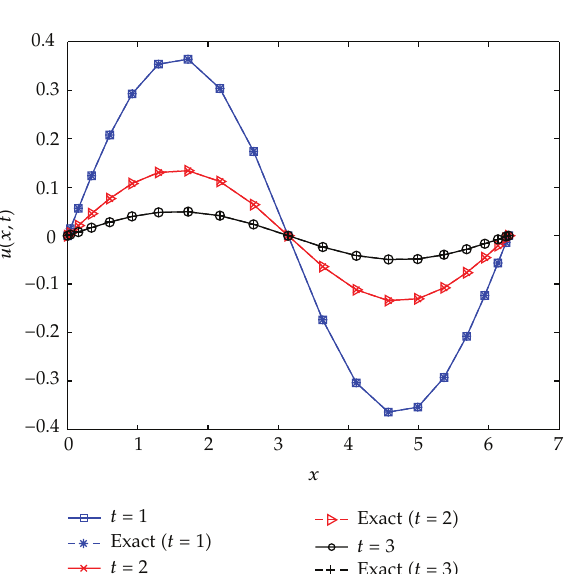
Figure 1: Numerical and exact solutions at di ff erent times for Problem 1, with Δ t (cid:6) 0 . 25, N (cid:6) 17 using Neumann boundary